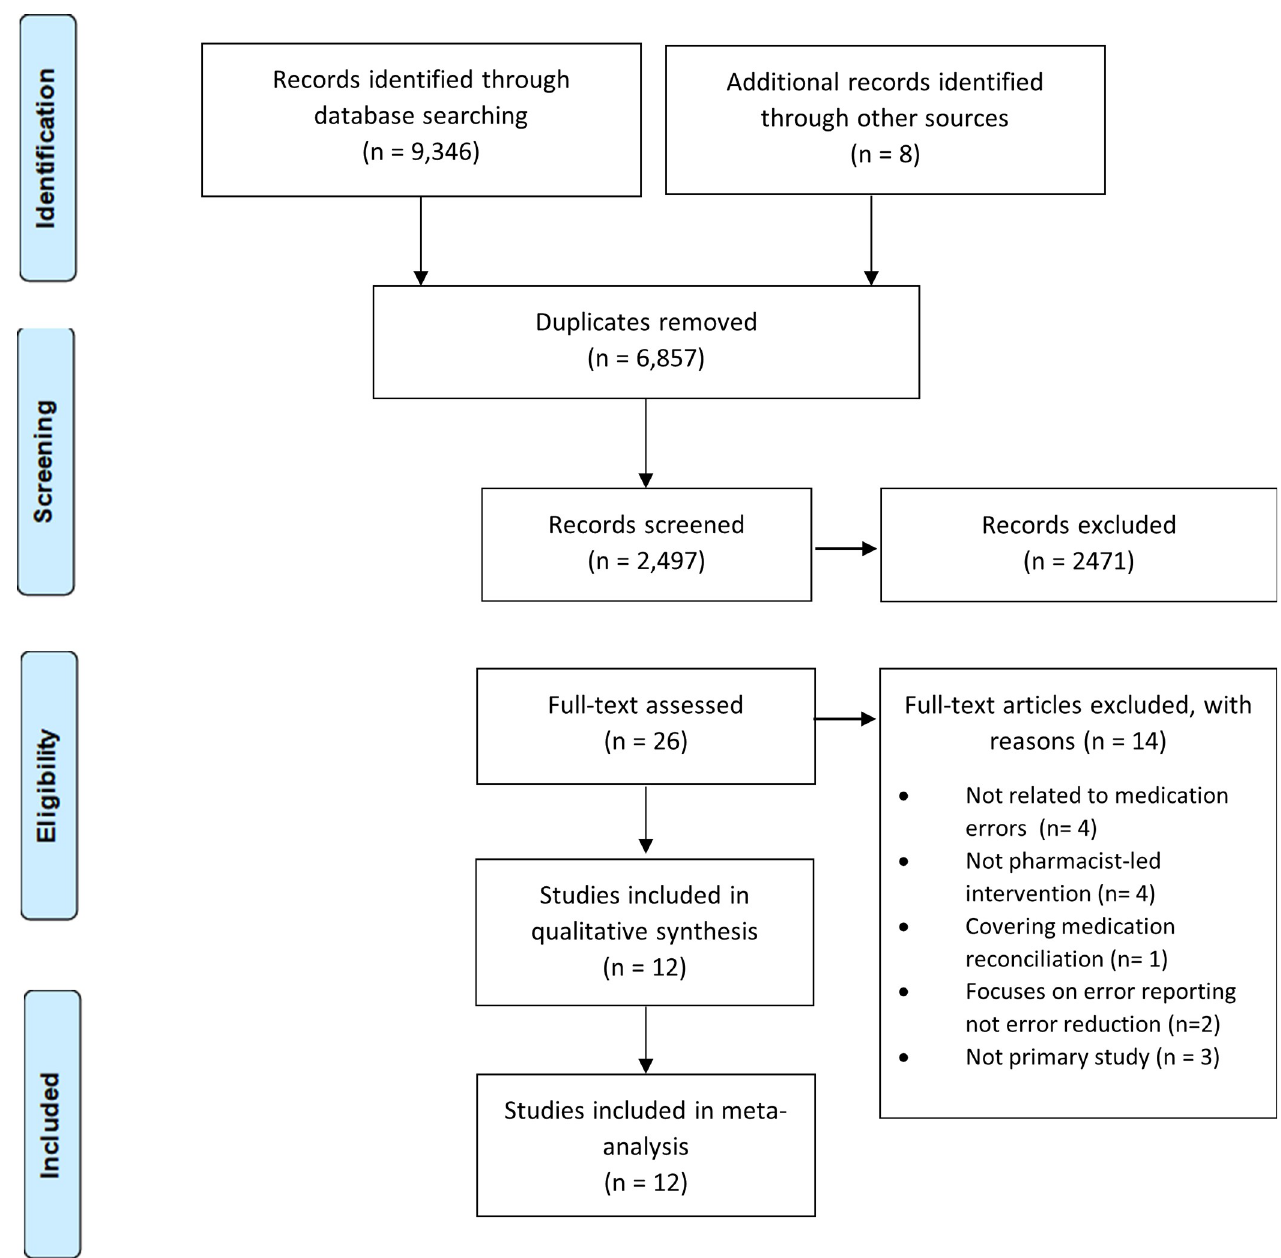
Fig 1. Prisma flow